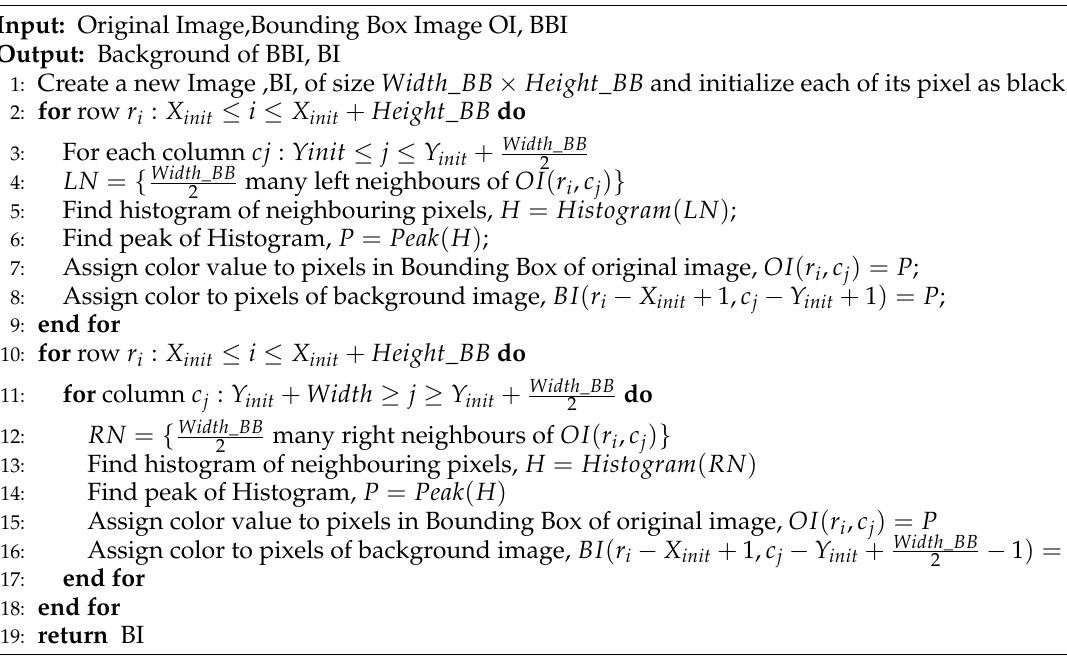
Algorithm 1 Background Modeling of BBI Algorithm